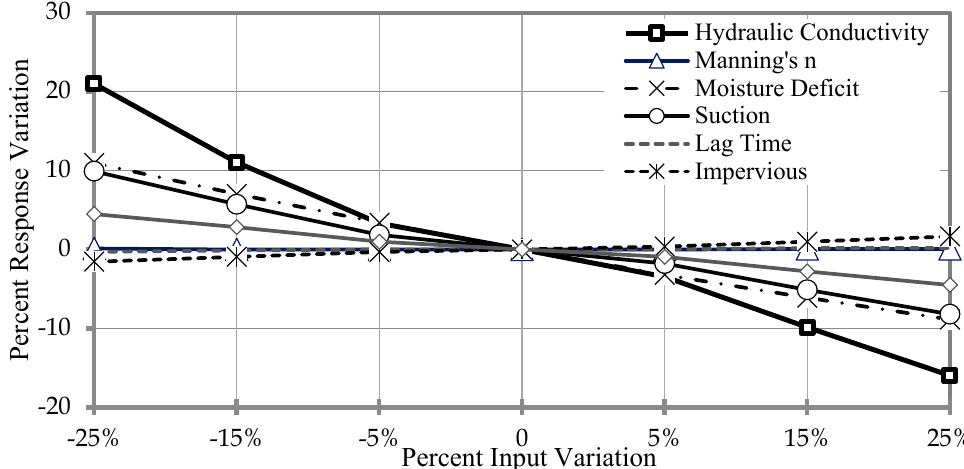
Figure 8. Sensitivity of peak flow rate to several input parameters for Green and Ampt method.